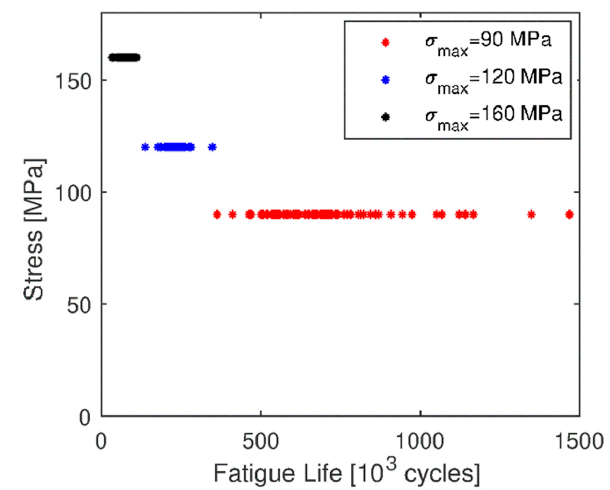
Figure 3. S - N graph for fatigue tests at three different levels of stress. Table 3. Average and standard deviation values for fatigue life.